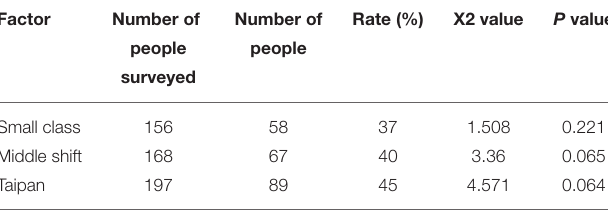
TABLE 3 | Comparison of health diagnosis and intelligence development of children in kindergarten a.